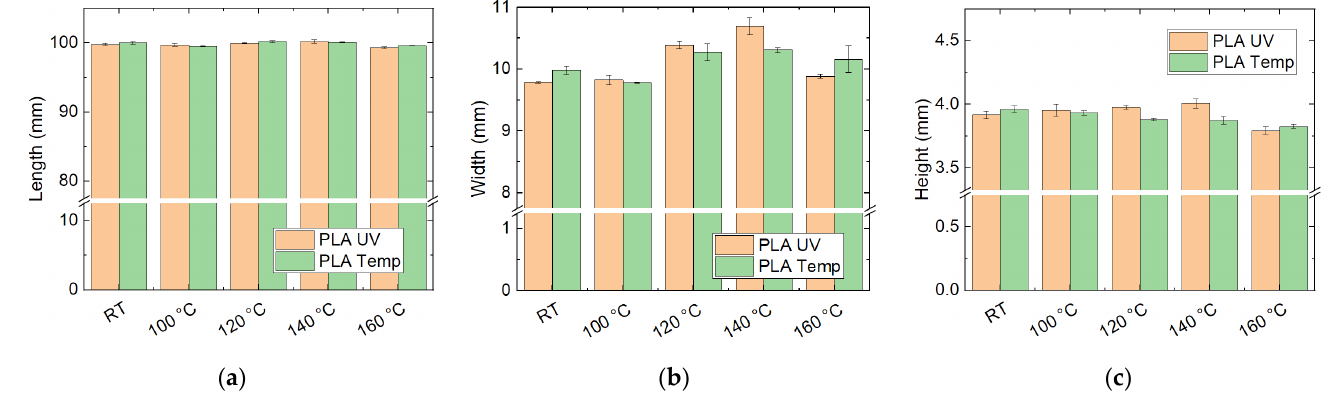
Figure 8. Dimensions of filled PLA samples, as printed (“RT”, room temperature) and heat-treated at different temperatures: ( a ) length; ( b ) width; ( c ) height.